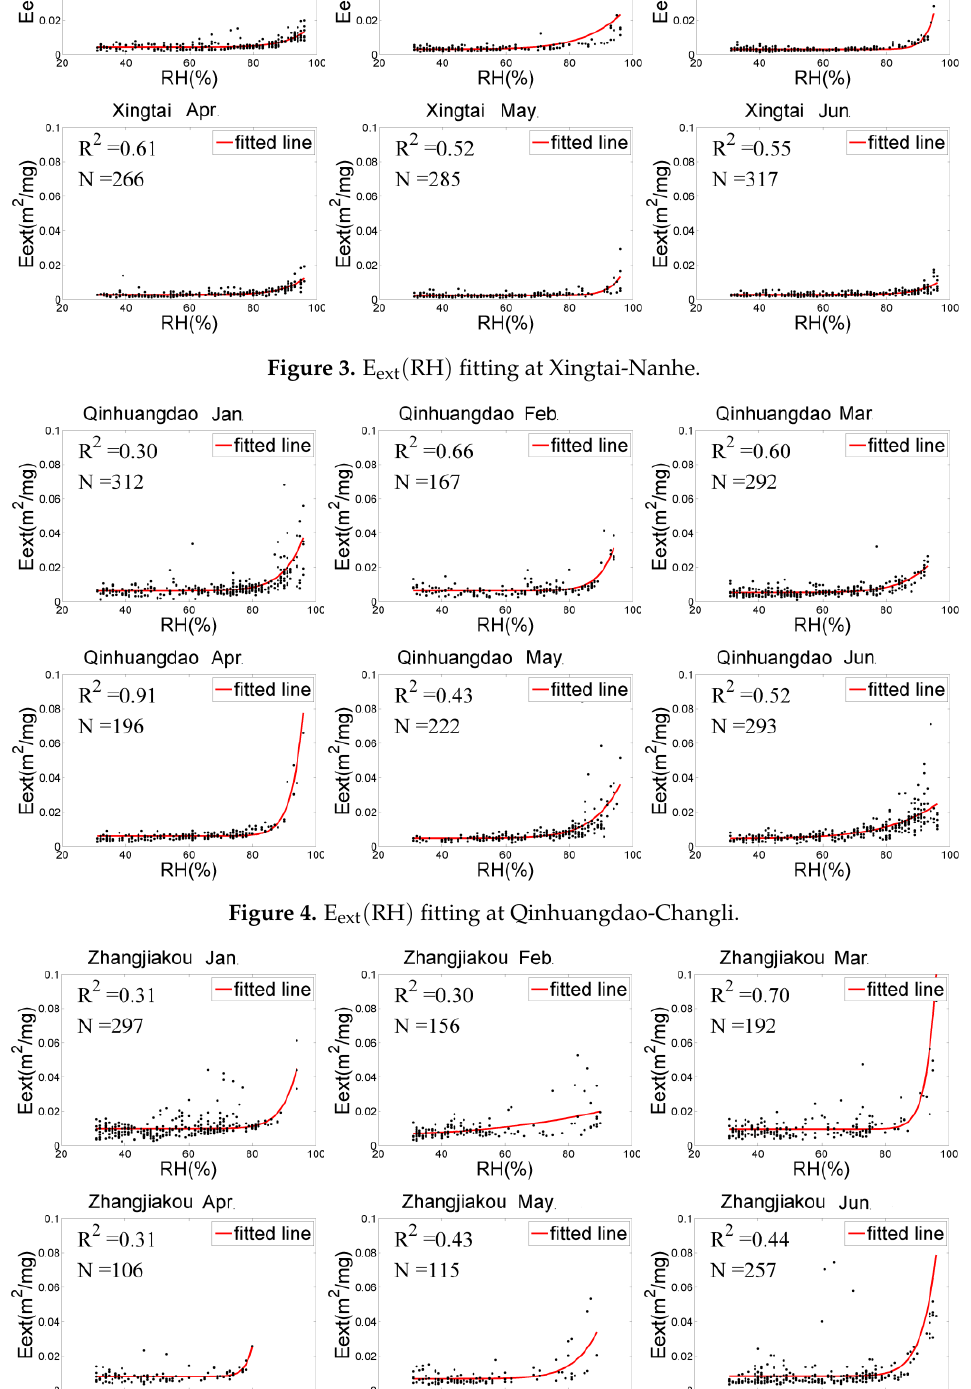
The monthly and half-year mean humidification factor values at RH = 80%, f ( 80% ) were calculated for the three sites by Equation (5), as listed in Table 2. The f ( 80% ) value in Qinhuangdao-Changli